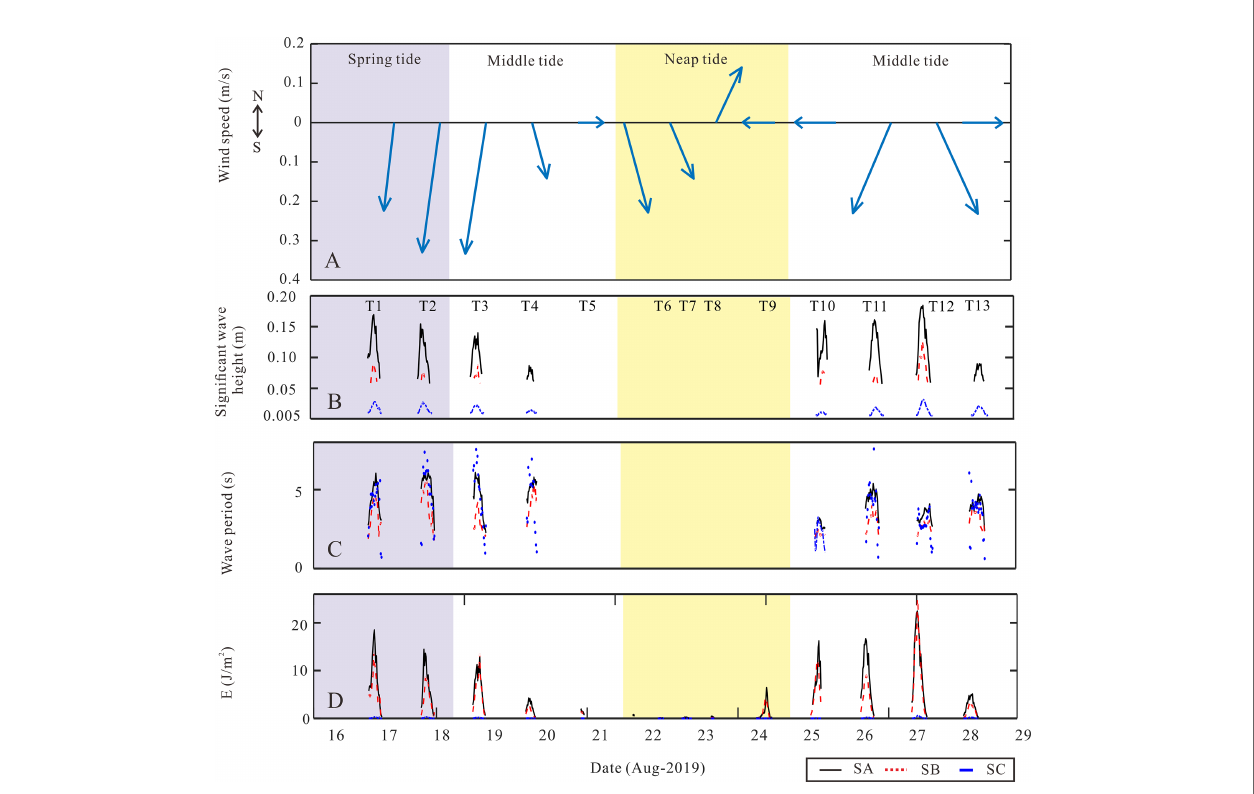
FIGURE 6 | Purple, white, and yellow shadows representing the periods during spring, middle, and neap tides, respectively. The fi gure describes (A) wind information during the observation period; (B) signi fi cant wave height; (C) wave period; and (D) wave energy. Data from the SA station are shown as black lines. Data from the SB station are shown as red dotted lines and data in the SC station are shown as blue lines. .